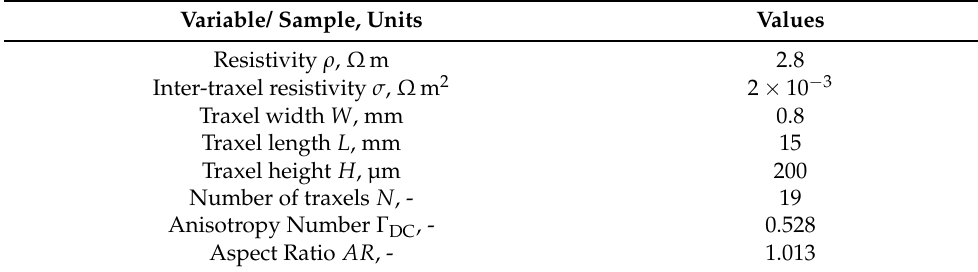
Figure 10. The results of the Matlab implementation of the model, showing the voltage, current density in x -direction, and the power density. The values presented in Table 2 are used as the model parameters, and traxels are modeled to be meandering at x = 0 (except for traxel 1, top ) and x = L (except for traxel 19, bottom ). This yields an anisotropy ratio of Γ = 0.528, indicating a small amount of anisotropic conduction. Table 2. The parameters used for modeling and simulations. Data from